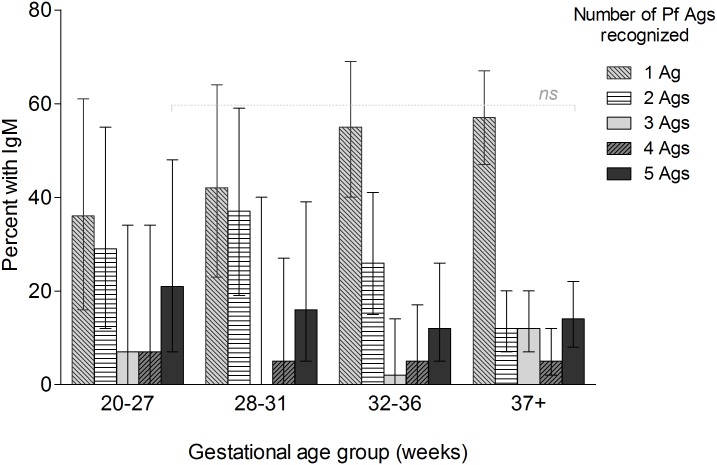
Breadth of Pf IgM response in different gestational age groups.The 169 Cameroonian newborns who were cord IgM+ to ≥ 1 Pf Ag were included, i.e., n = 75 preterm [n = 14 (20–27 weeks), n = 19 (28–31 weeks), n = 42 (32–36 weeks)] and n = 95 term. For each GA group, the bars show the proportion of Ab-positive newborns who produced IgM recognizing 1, 2, 3, 4 and 5 Pf blood-stage Ags. Whiskers represent the 95% confidence interval of proportions. There were no significant (ns) differences in responders to multiple antigens across GA groups.